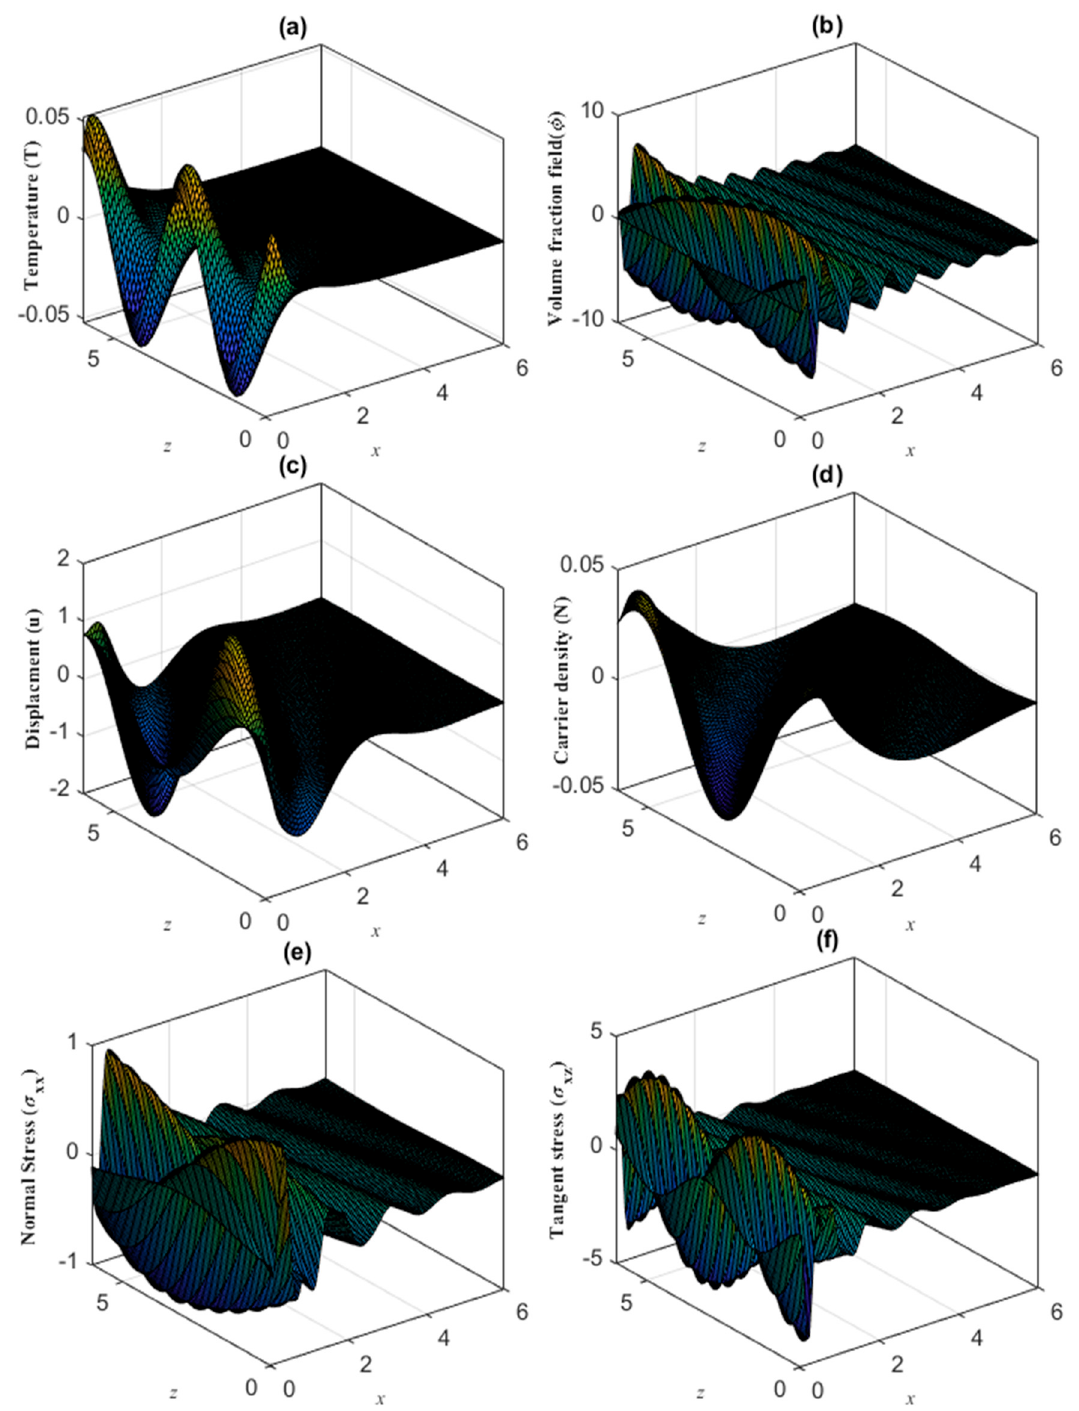
Figure 3. ( a–f ) Variation of the main physical distributions w.r.t the vertical and horizontal distance under the impact of porosity according to the GL model. under the impact of porosity according to the GL